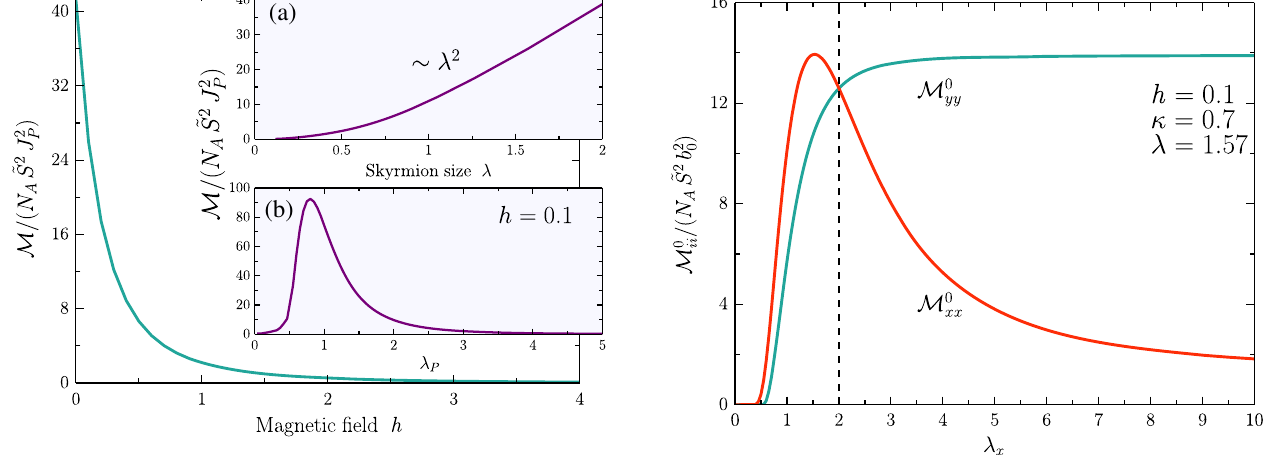
FIG. 7. Dependence of the mass terms M 0 and M 0 on the xx yy trap size λ of an anisotropic magnetic trap of strength b 0 ¼ 0 . 01 x 2 . The Skyrmion configuration is described by the and fixed λ y ¼ parameters κ ¼ 0 . 7 , h ¼ 0 . 1 , and λ ¼ 1 . 57 . The dashed vertical 2 line indicates the location of λ y ¼